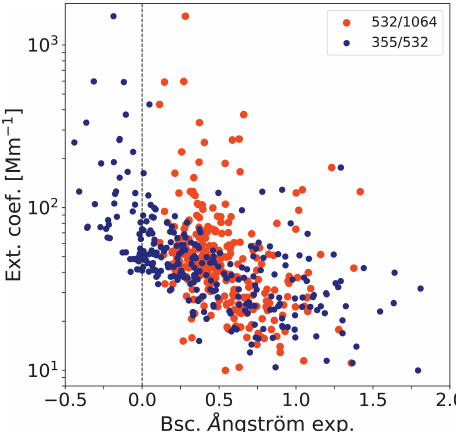
Figure 10. Correlation between the backscatter-related Ångström exponents (blue: 355–532nm spectral range; red: 532–1064nm spectral range) and the 532nm particle extinction